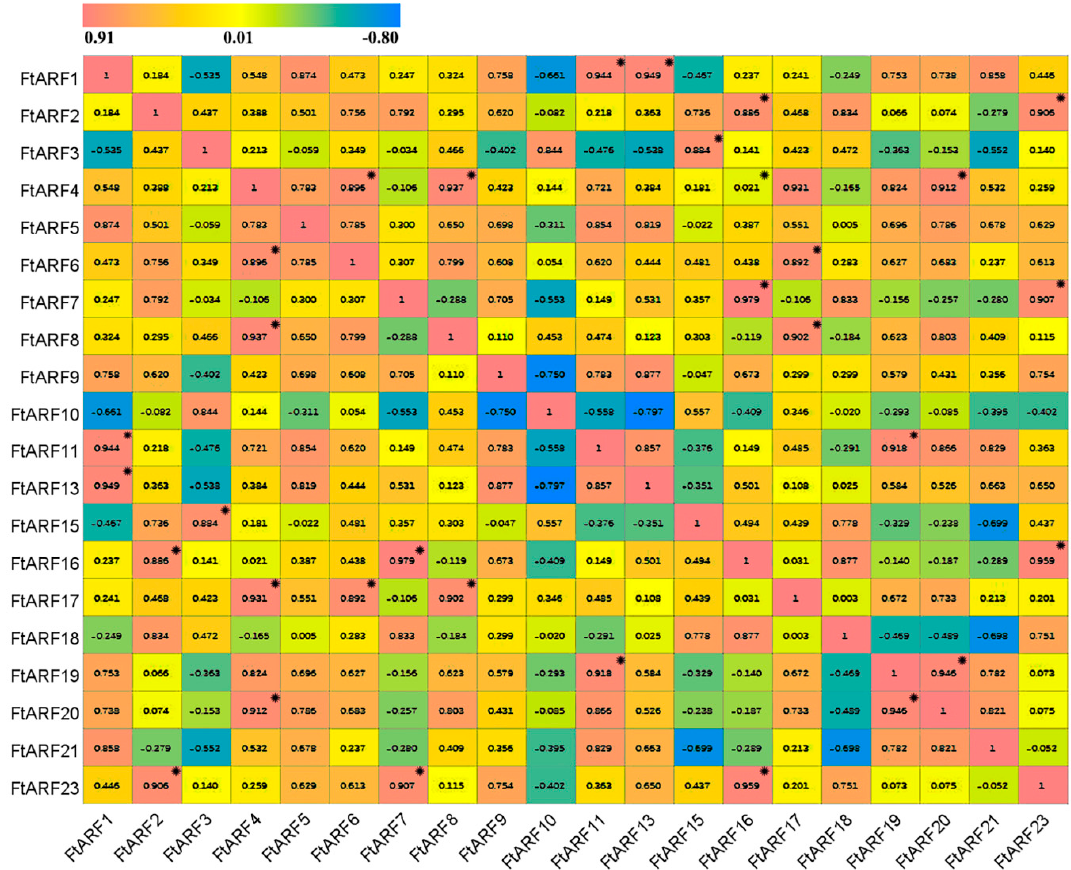
Figure 5. The correlations between the gene expression of the FtARFs in flower, leaf, root, stem, and fruit tissues. Red: positively correlated; blue: negatively correlated. * indicates significant correlation at 0.05 levels.